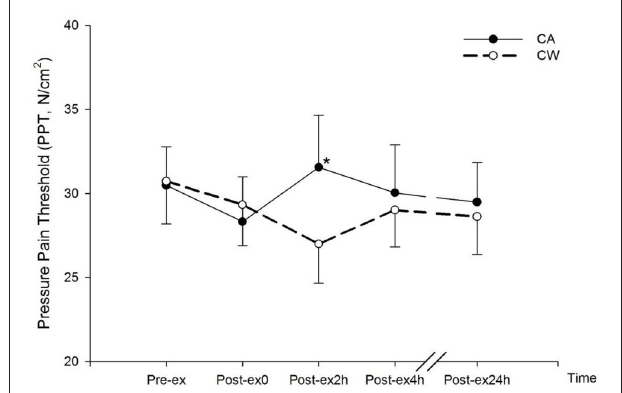
TABLE 1 | Change of body weight and hemoglobin following main trials.